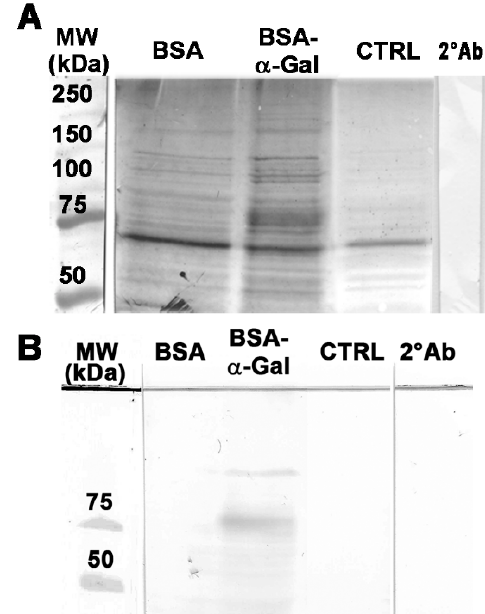
Figure 4. Immunoblot detection of BSA and BSA- α -Gal using ( A ) polyclonal anti-BSA antibody and ( B ) monoclonal anti- α -Gal M86 antibody in the endosomal fraction obtained by differential centrifugation of Caco-2 cell lysates after 4 h of incubation, 2°Ab = control of unspecific binding of secondary antibody, MW = Molecular weight markers, and CTRL = unstimulated Caco-2 cells.